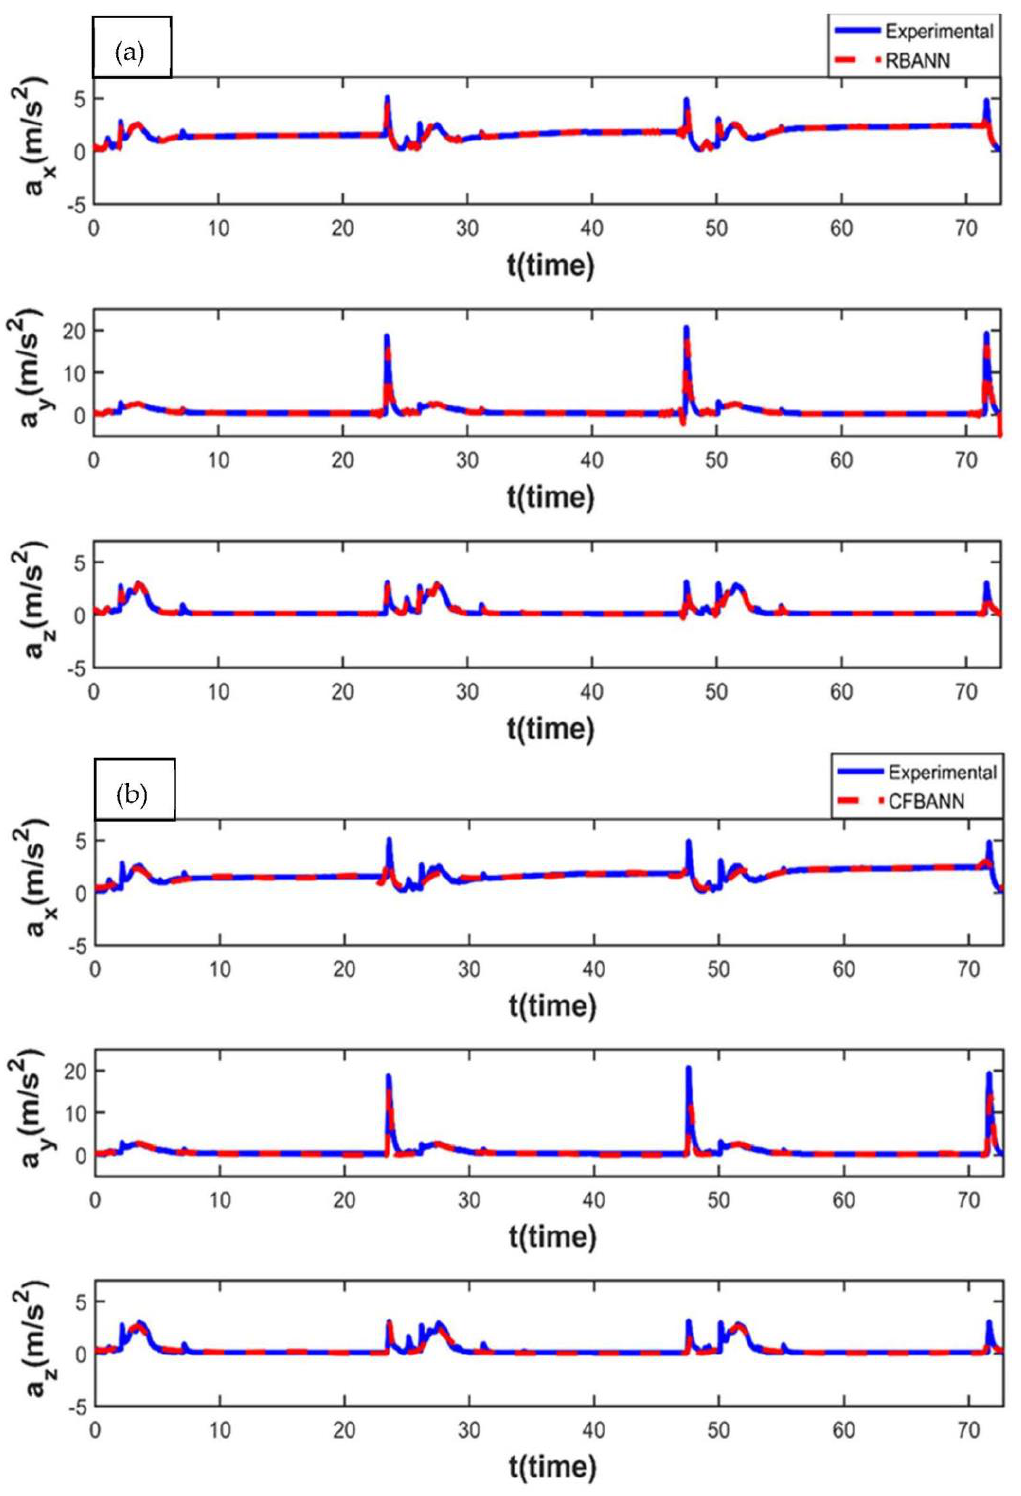
Figure 16. Experimental and ANN results obtained for the working condition of 20 s and 37.5 bar: ( a ) RBANN; ( b ) CFBANN.